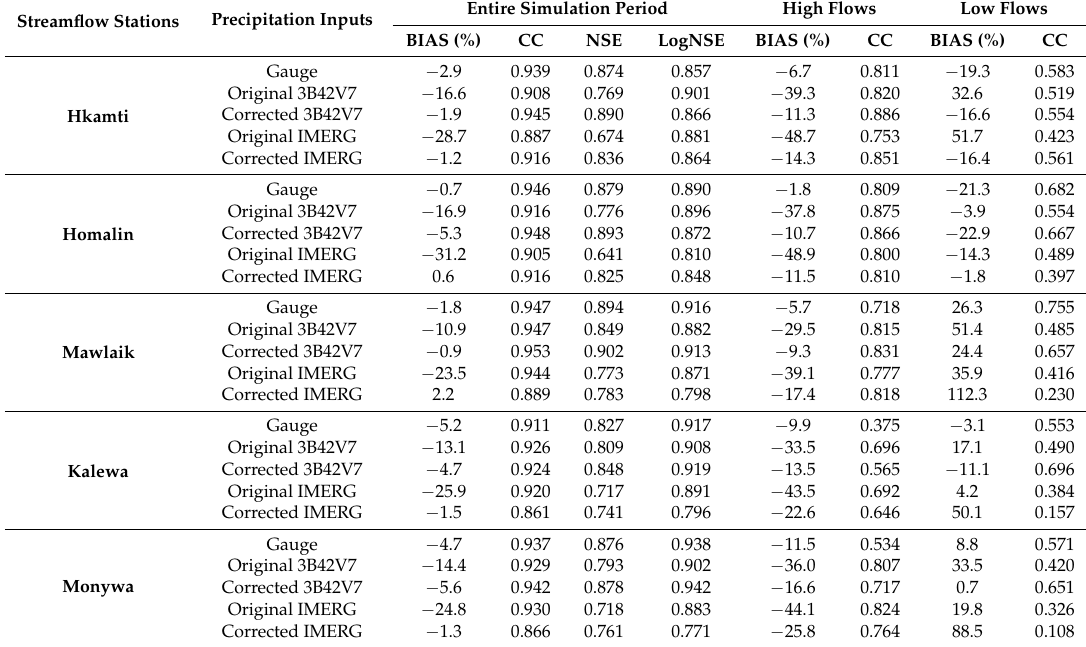
Table 4. Statistical indices of the simulated daily streamflow processes at the five weather stations in the Chindwin River basin (1 April 2014–31 December 2015). Streamflow